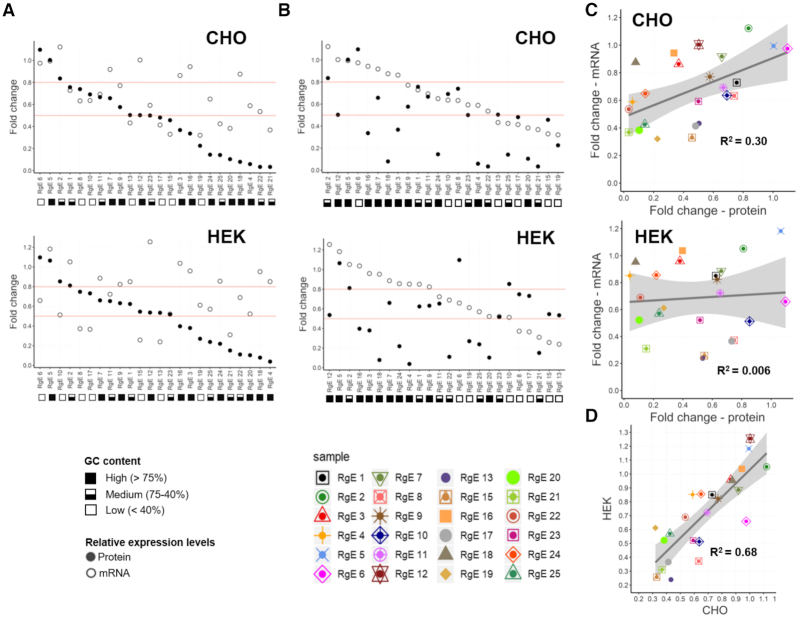
mRNA expression level analysis. (A and B) Observed average fold changes in RFP expression levels on the protein (taken from Figure 2C and D, full dots; n = 3 independent samples each) and mRNA level (open dots; n = 2 independent samples each; see Supplementary Figure S6 for individual values) for CHO (top) and HEK (bottom) cells ordered in decreasing order for protein expression levels (A) and mRNA levels (B). RNA to protein fold change ratio is depicted in Supplementary Figure S7. The red lines highlight specific fold changes that should simplify evaluation of fold change and impact of mRNA levels. (C) Average fold changes of mRNA levels plotted against fold changes on protein level for CHO (top) and HEK (bottom) cells. (D) Average mRNA fold changes of CHO versus HEK cells. Gray area shows standard error.